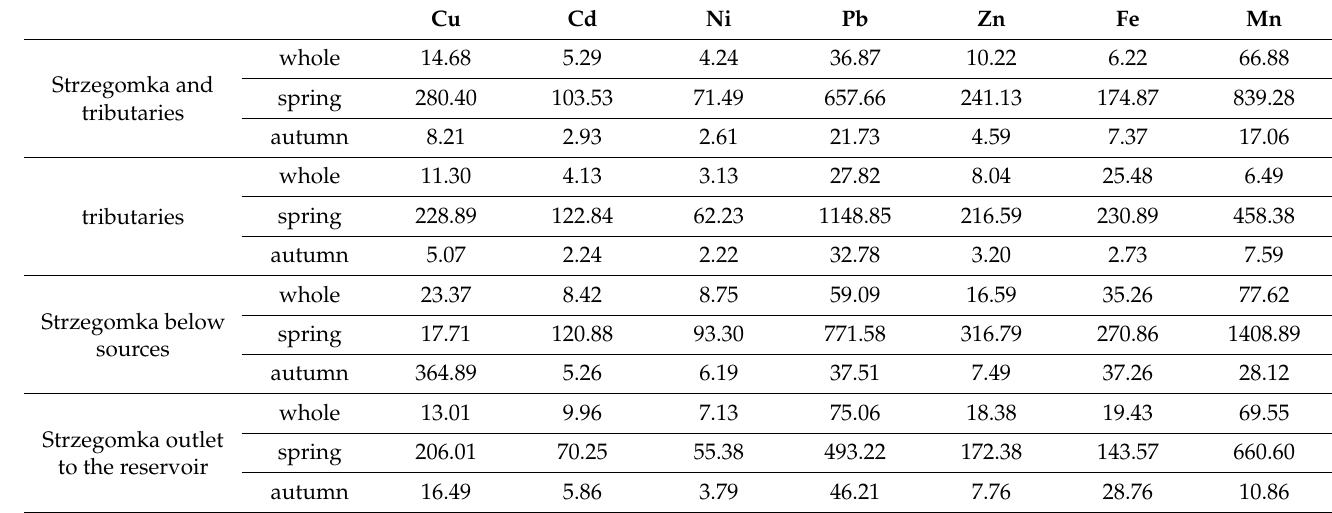
Table 15. Enrichment factor (EF) in reed canary grass from the Strzegomka River. Cu Cd Ni Pb Zn